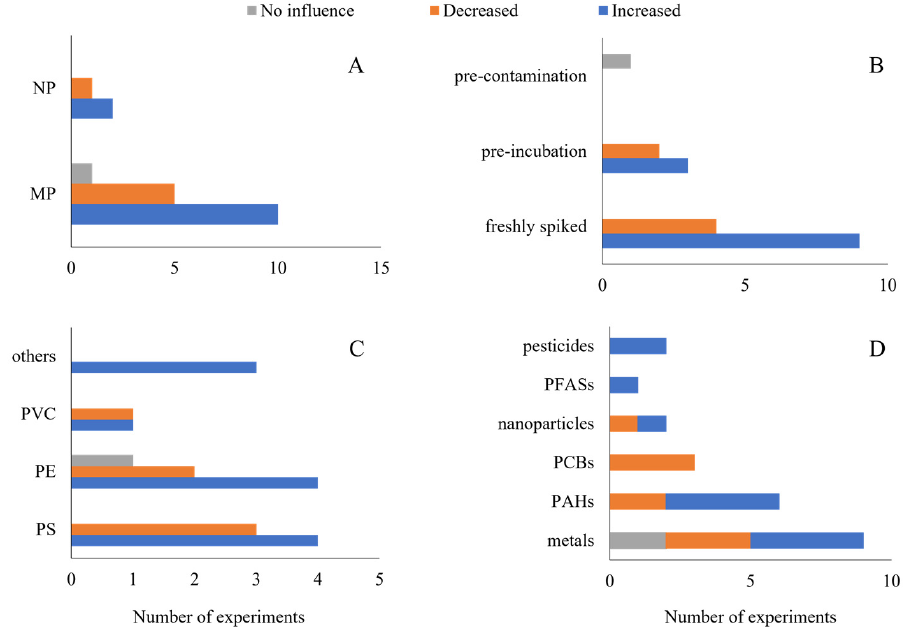
Figure 4. Outcome on the influence of nano- and microplastics (NMPs) on the bioaccumulation of contaminants in earthworms. Studies’ characteristics are shown as ( A ) particle size, ( B ) spiking procedure, ( C ) type of polymer, and ( D ) type of contaminant. NPs: nanoplastics; MPs: microplastics; PVC: polyvinyl chloride; PE: polyethylene; PS: polystyrene; PFASs: per- and polyfluoroalkyl substances; PCBs: polychlorinated biphenyls; and PAHs: polycyclic aromatic hydrocarbons.